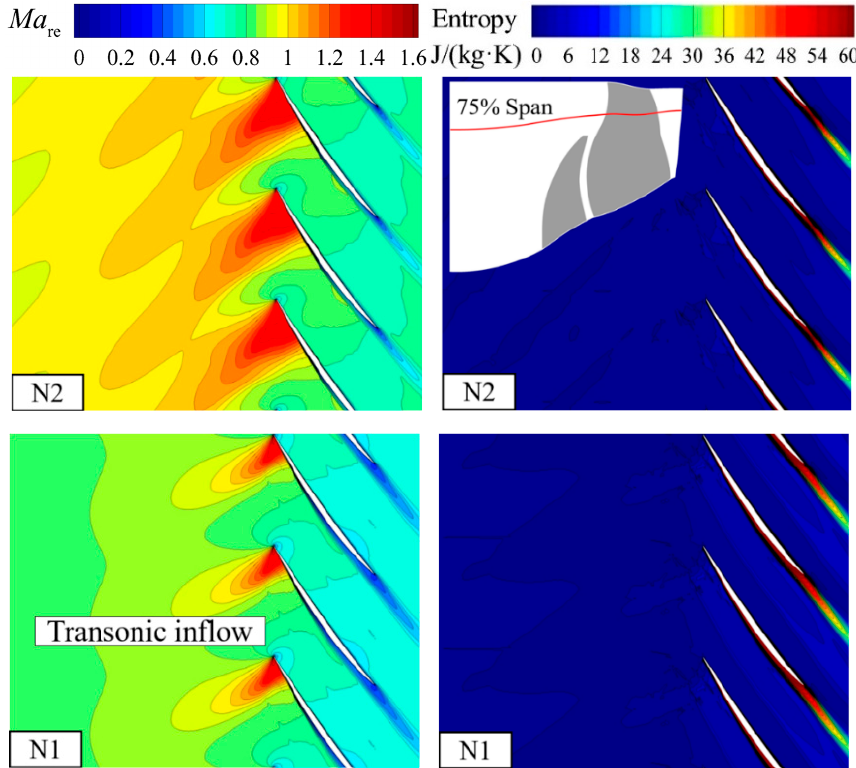
Figure 19. Ma re and entropy contour at 75% span of the tandem rotor.